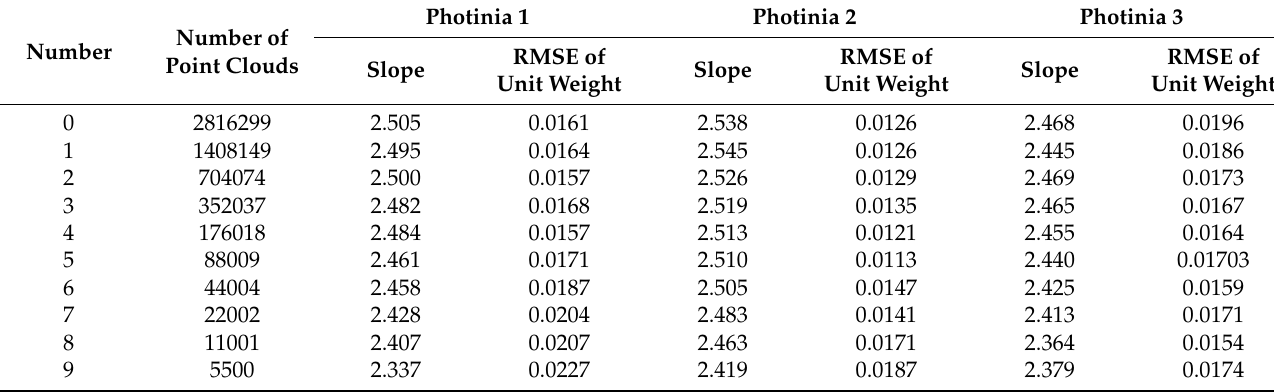
Table 4. Fractal dimension of photinia tree 1 with different number and density of point